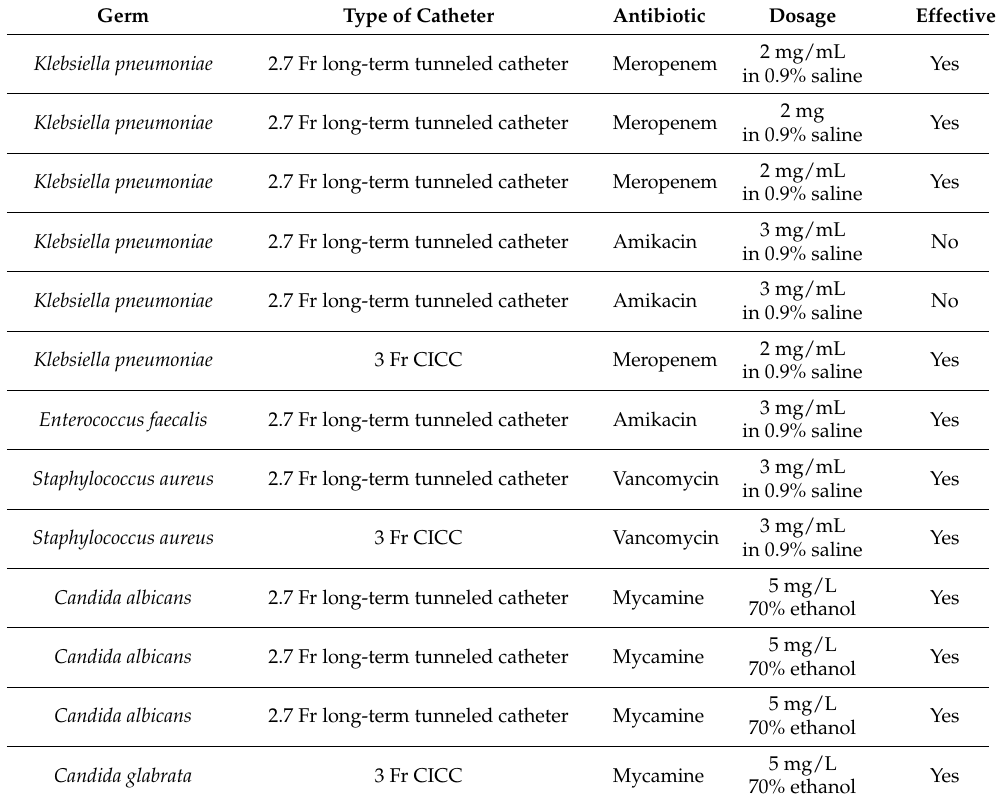
Table 3. Characteristics of the antibiotic locks